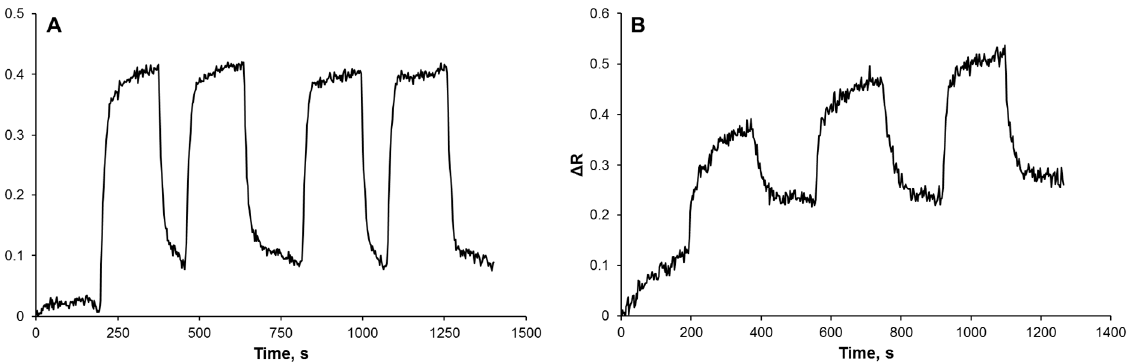
Figure 4. Reusability performance of Cu(II)-imprinted plasmonic sensor in the same ( A ) and differ- ent ( B ) Cu(II) concentrations. ( B ) Cu(II)